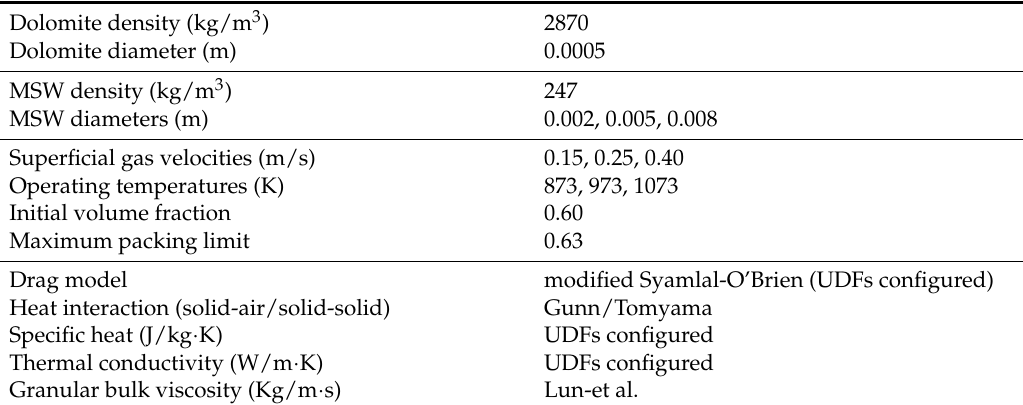
Table 2. Bed configurations and simulation parameters [16,30–32].